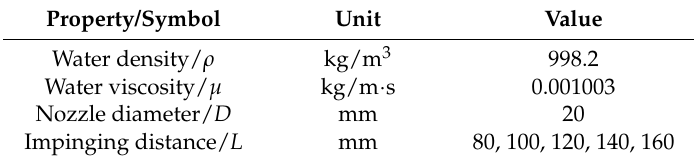
Table 3. Properties of water and geometric parameters of the impinging stream